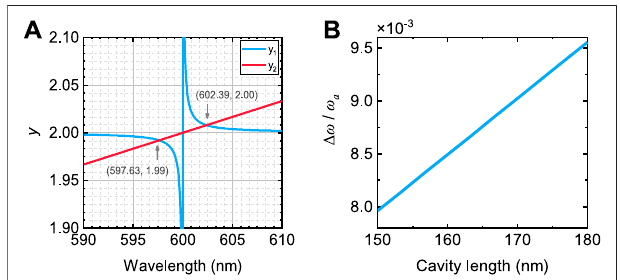
FIGURE 6 | Process and result of graphical method or formula for roots tosolve Eq.25 . (A) Graphofthetwofunctionsin Eq.26 forgraphicalmethod. The abscissa of two points of intersection correspond to the two splitting peaks in the transmission spectrum for cavity medium with Lorentz- dispersion. (B) Theoretical analysis results of the in fl uence of cavity length on the relativesplittingdegree Δω / ω a . Compared with Figure 2C , this theory can explain Δ ω / ω a increases